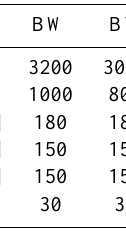
Table 1. CPs classified by automated fuzzy rule-based algorithm. Table 2. Parameters used for valley